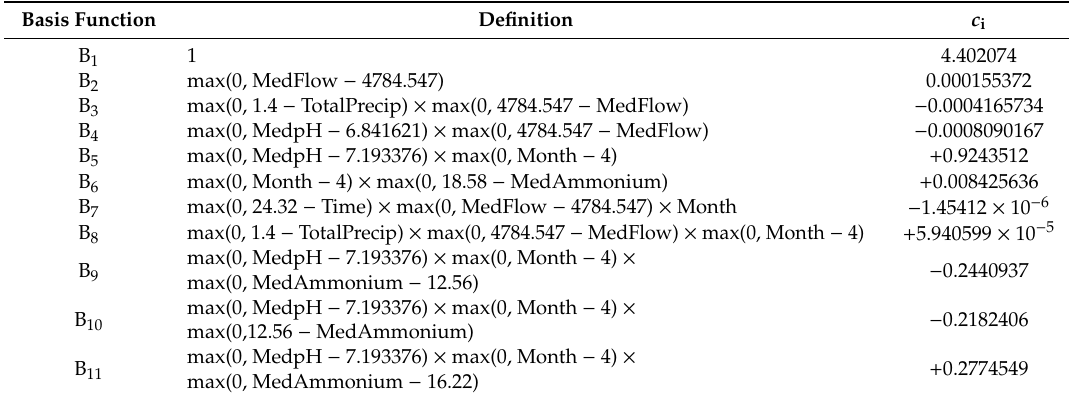
Table 3. List of basic functions of MARS model.